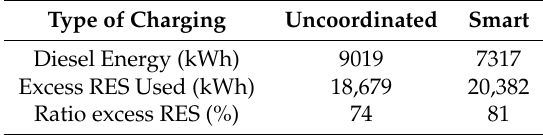
Table 6. Diesel Generation and RES pwer excess used for charging EV for Scenario